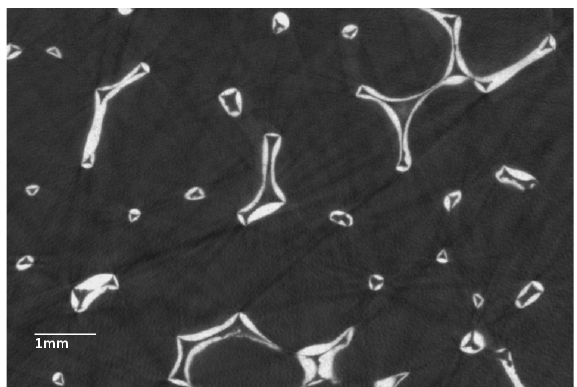
Figure 6. X-ray picture of alumina layer on FeCrAl